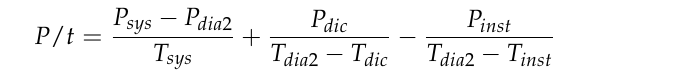
Table 1. The ten extended parameters including four different ratios, time to time, time to area, area to time, and area to area. Ratio Parameter Ratio Parameter LVET/HD A1/A Time to Time Area to Area ER/HD A2/A LVET/A1 A1/LVET ER/A2 A2/ER Time to Area Area to Time HD/A